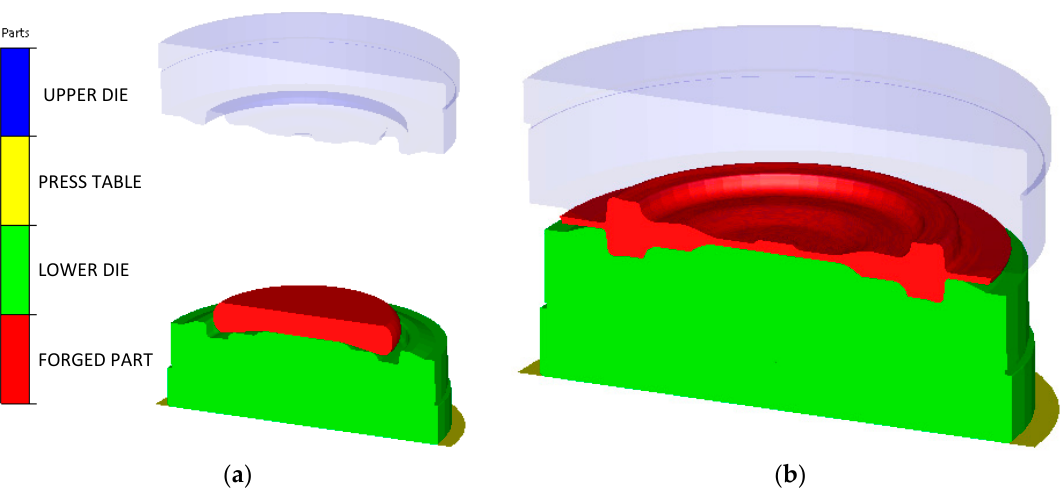
Figure 2. General view of the FEM model: ( a ) before; ( b ) after 2nd forging operation.